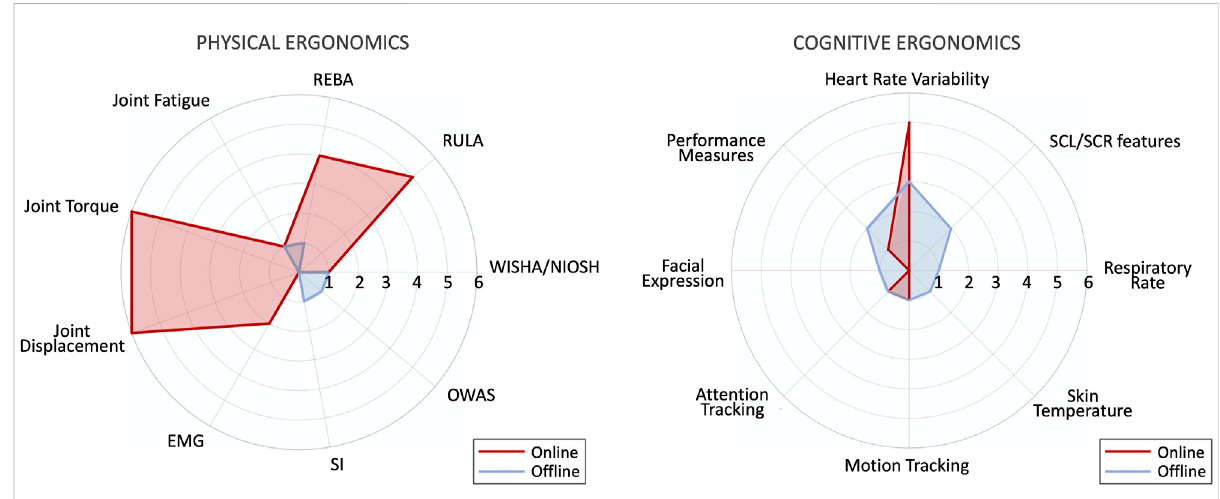
FIGURE 5 Number of papers related to the main assessment variables in physical and cognitive